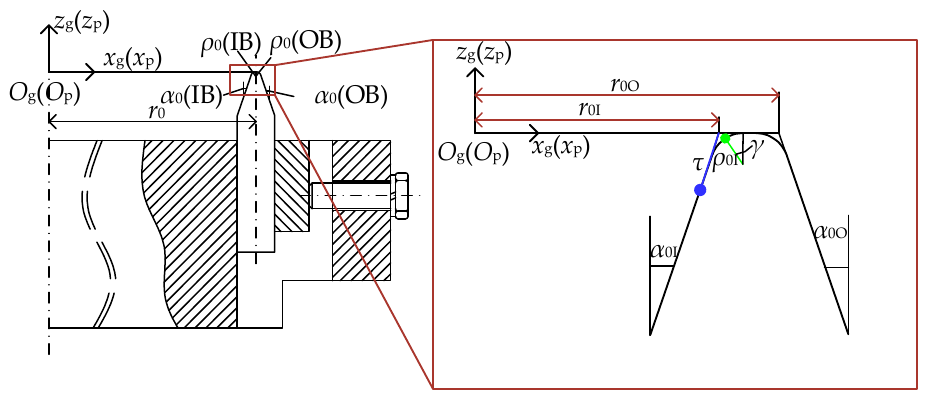
Figure A3. Schematic of the cutter.